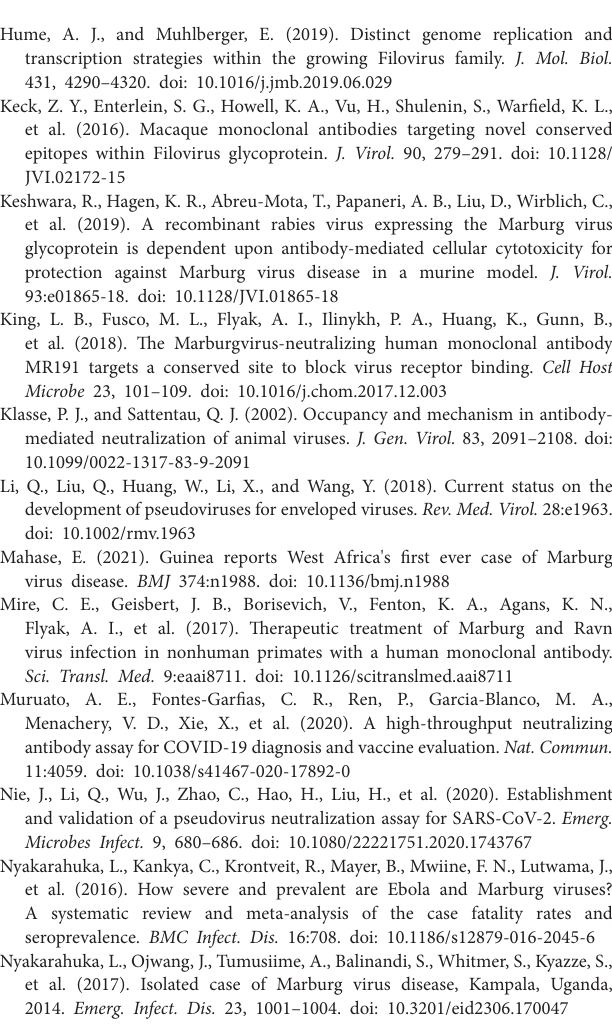
Supplementary Figure 1 | Western blot analysis of different antibodies and pseudoviruses. Supplementary Figure 2 | Sequencing results of the fifth generation pseudovirus genome identified by RT-PCR. Colored sequences are the samples that were sequenced and correspond to the standard sequences. Supplementary Figure 3 | Sequencing results of the tenth generation pseudovirus genome identified by RT-PCR. Colored sequences are the samples that were sequenced and correspond to the standard